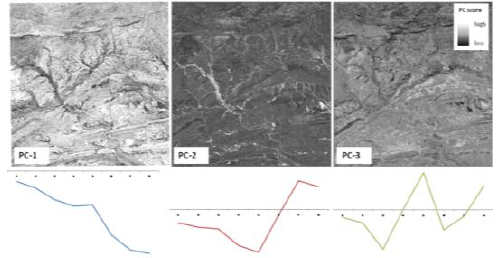
Figure 3: The first three principal components for the vegetation image. Eigenvector values for each PC are presented below the associated image. These graphs illustrate the weighting of each WV-2 band (from 1 to 8) expressed in each principal component. For example, Eigenvectors for PC-2 show low levels in band 5 (red) and high in the NIR bands 7 and 8, thus land cover components with a strong difference between red and near infra red, such as actively growing vegetation are highlighted in this image.